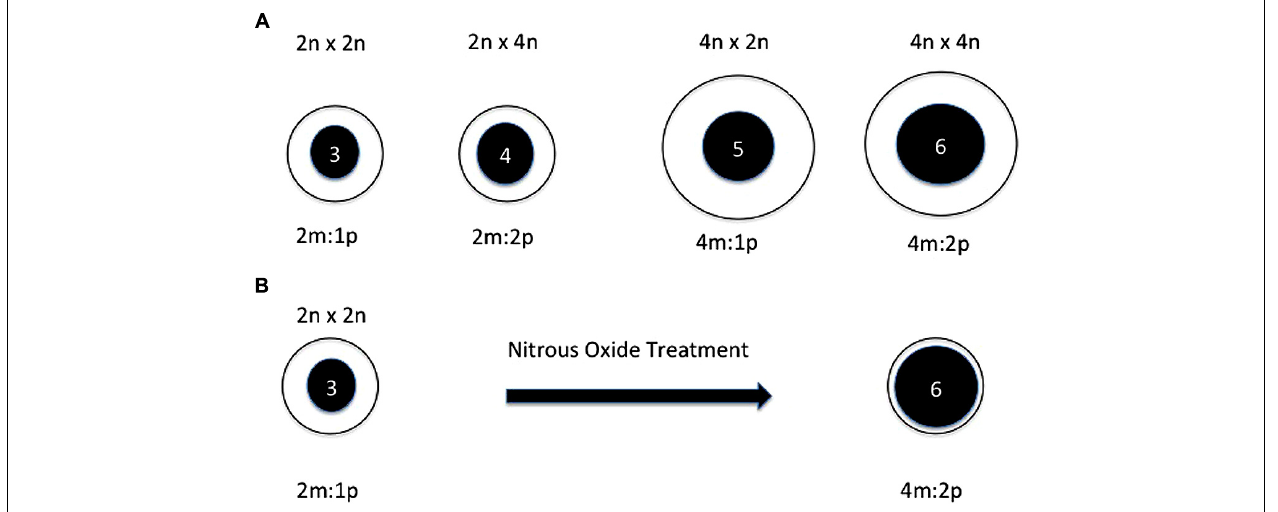
maternal to paternal contributions are changed as is the maternal gametophytic relationship to the genomic dosage after fertilization. (B) Depiction of the primary endosperm cell before and after chromosome doubling via nitrous oxide treatment. At the left is depicted a primary endosperm cell from a normal diploid plant. At the right is shown a depiction when the nucleus is doubled in chromosome number from triploid to hexaploid in the progenitor smaller cell. In the latter, even though the maternal to paternal relationship is the same as a tetraploid, the maternal gametophytic contributions would be typical of a diploid but with a doubled genome with which to interact. Based on a figure from Bauer